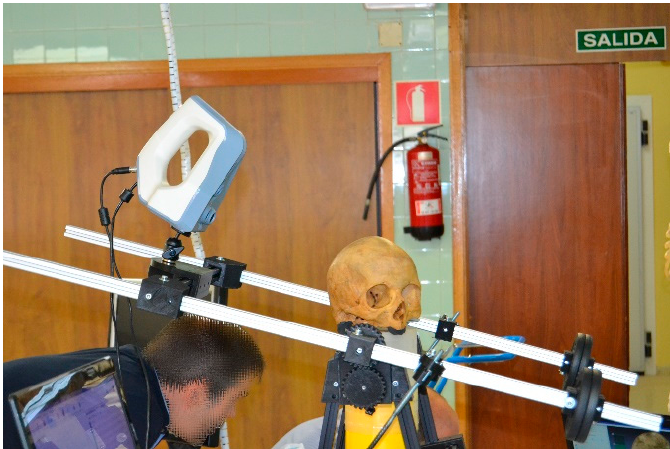
Figure 8. Prototype with mounted scanner (Source: self-made).